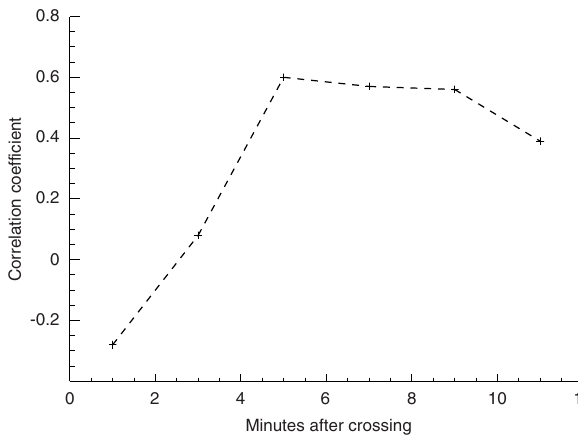
Fig. 7. Temporal evolution of the correlation coefficient of the ra- tios I(l)/I(r) and T p ⊥ /T p k downstream of the quasi-perpendicular low- β bow